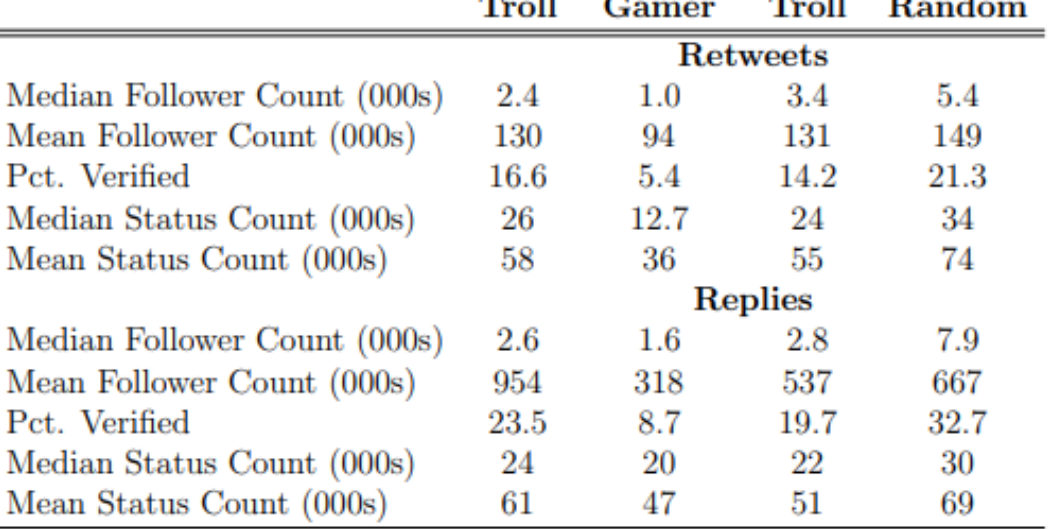
Table 1. Externally Targeted Accounts